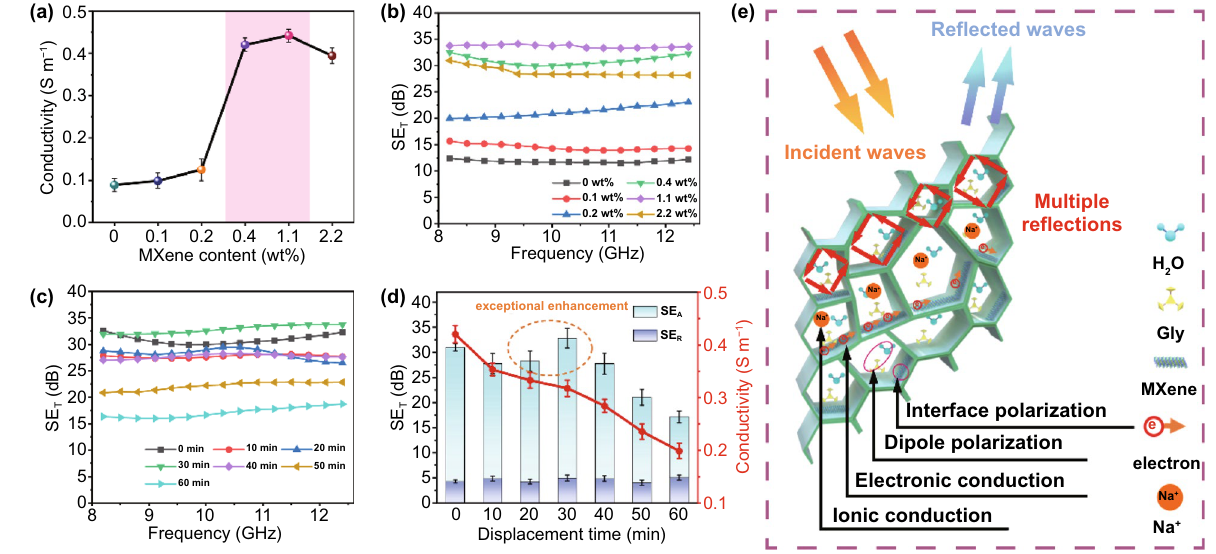
Fig. 4 a Variation of conductivity of MXene hydrogel with MXene content. b EMI SE T curves of MXene hydrogels containing different MXene contents. c EMI SE T curves of MXene organohydrogels prepared at different water-Gly (1:1) displacement time. d Variations of conductivity and average SE T of MXene organohydrogel with water-Gly displacement time. e Scheme showing the EMI shielding mechanism of MXene organo-